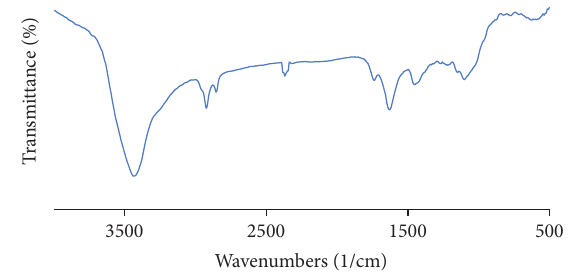
F 4: FTIR spectra of capped CdO nanoparticles synthesized using the �ower extract of A. wilhelmsii